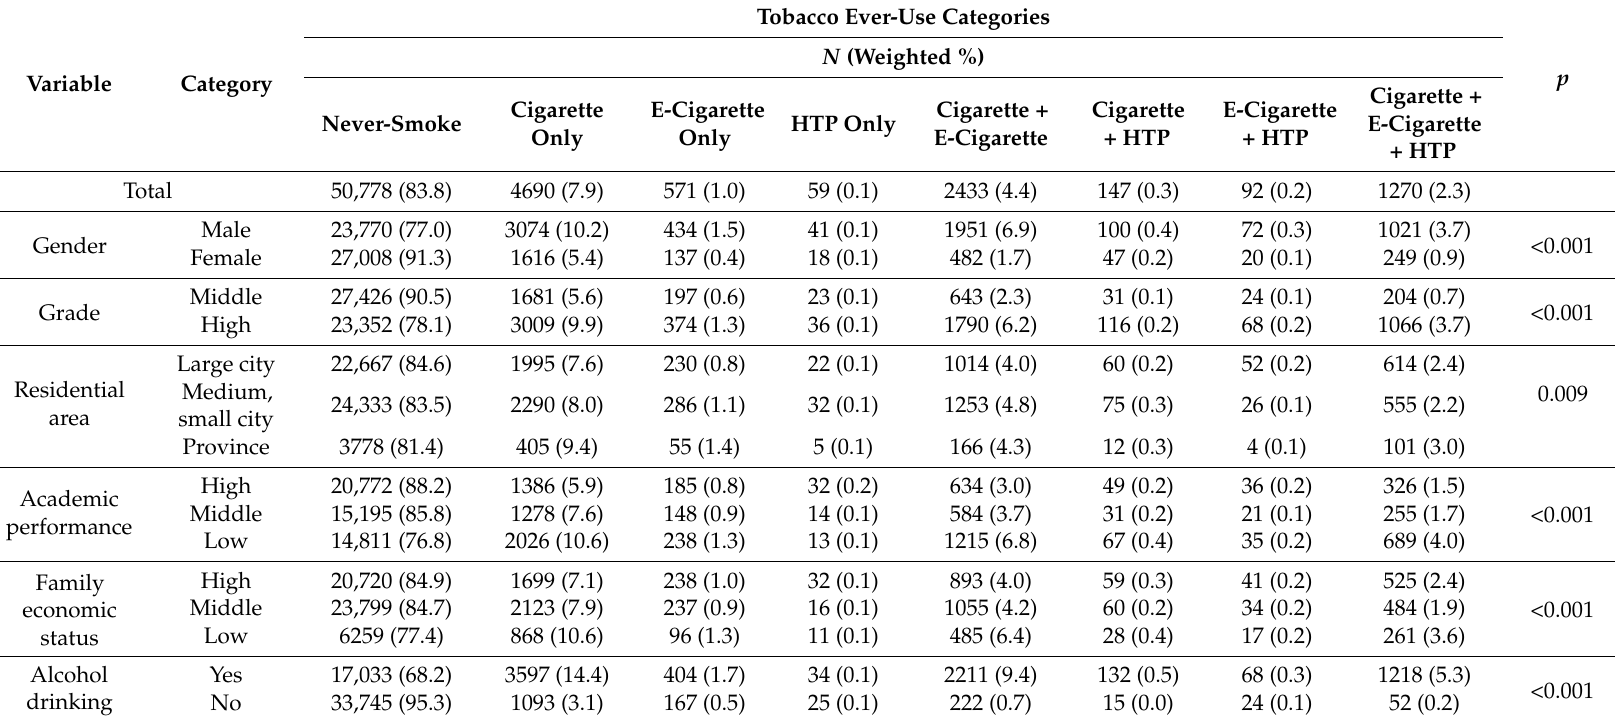
Table 1. General characteristics according to tobacco ever-use